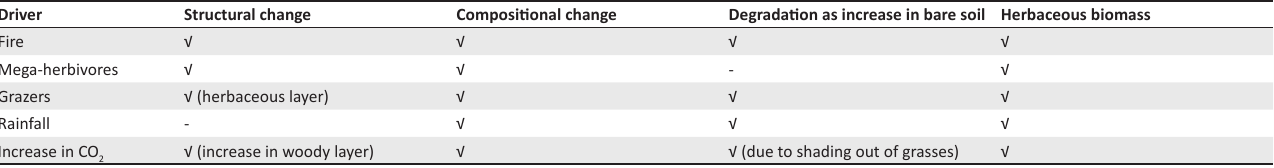
TABLE 5: Summary of the drivers that may be responsible for exceedences of thresholds of potential concern. A tick indicates that the driver may influence this vegetation response and should therefore be associated with monitoring for the specific driver. Driver Structural